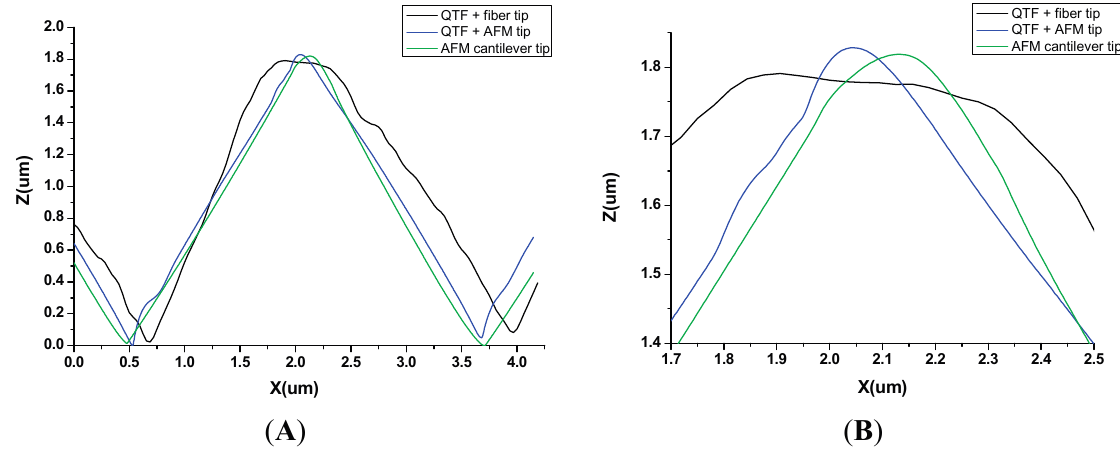
Figure 5. ( A ) Direct comparison of the topographic profiles of one of the features of the imaged calibration pattern with: QTF with fiber, QTF with AFM tip and with AFM cantilever tip; ( B ) Magnified image of the edge of the pyramidal structure. Notice that about 6 blue peaks fit within the black naked fiber